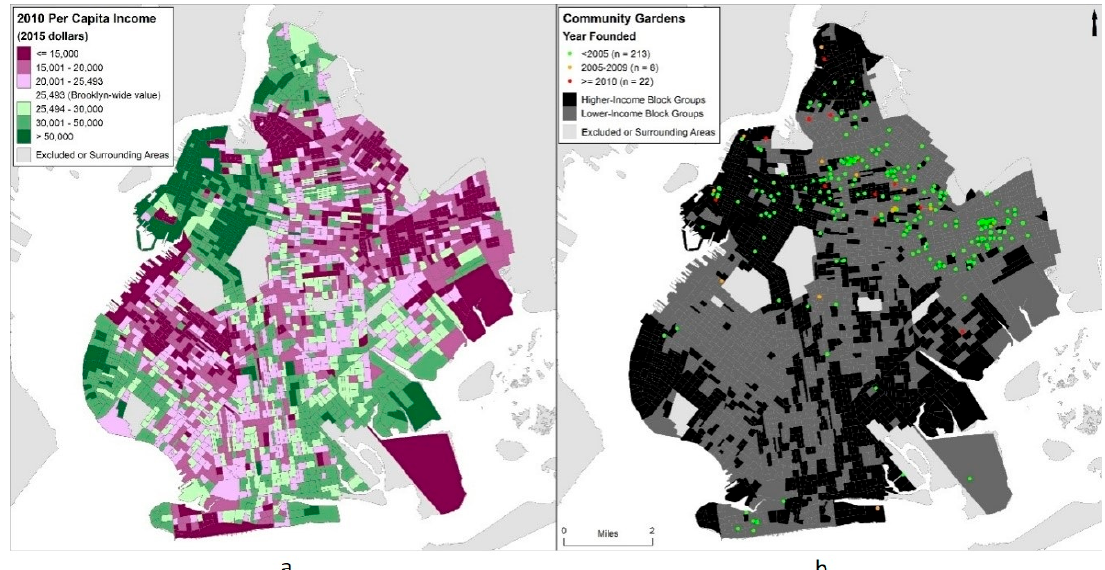
Figure 2. ( a ) Per capita income (2010) in Brooklyn, NY with colors diverging from the Brooklyn-wide per capita income estimate ($25,493 in 2015-adjusted dollars). ( b ) Locations of community gardens shown by year founded and lower-income and higher-income census block groups (2010).